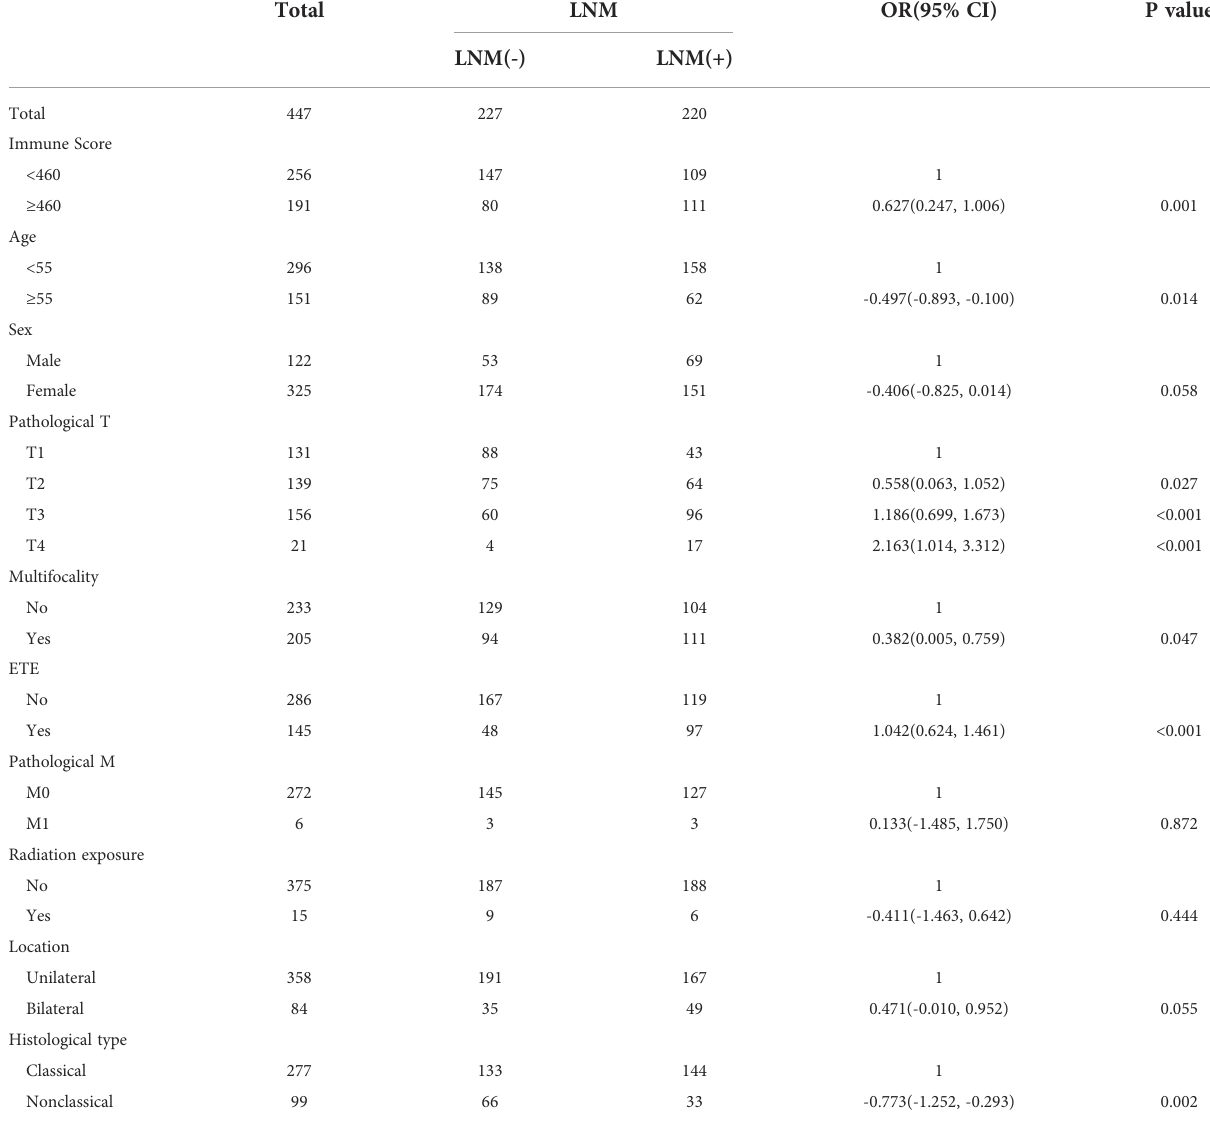
TABLE 2 Univariate analyses of LNM among PTC patients according to clinical-pathological characteristics and immune